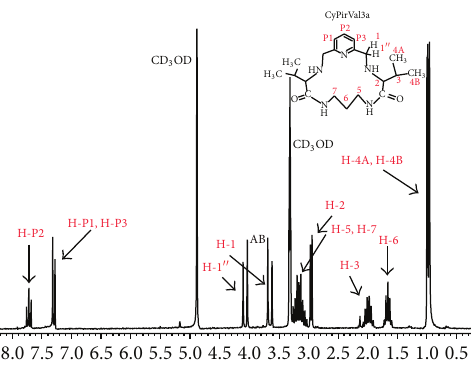
Figure 4: 1 H NMR spectrum of CyPirVal3a in CD 3 OD.